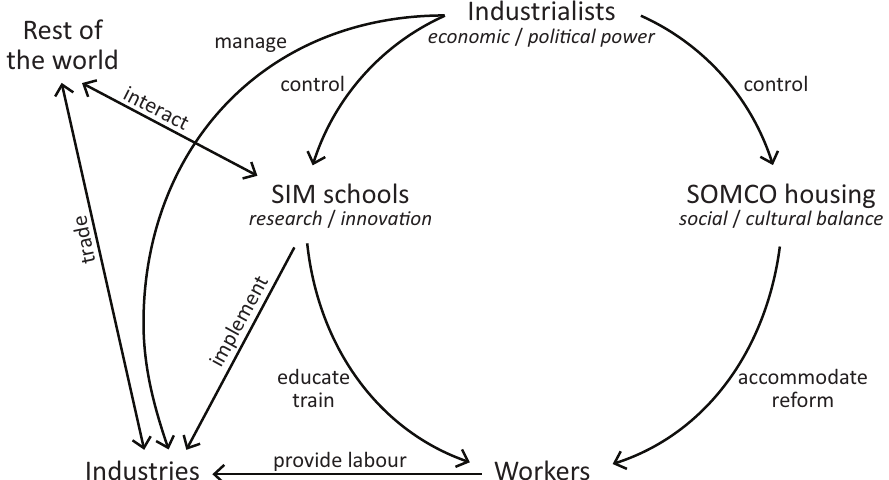
Figure 4. Diagram of the Mulhousian social model, featuring the agents and their relations. Source: Author’s work, based on M. Fou’s diagram (https://commons.wikimedia.org/wiki/File:Modele_mulhousien.png). Urban Planning, 2022, Volume 7, Issue 1, Pages